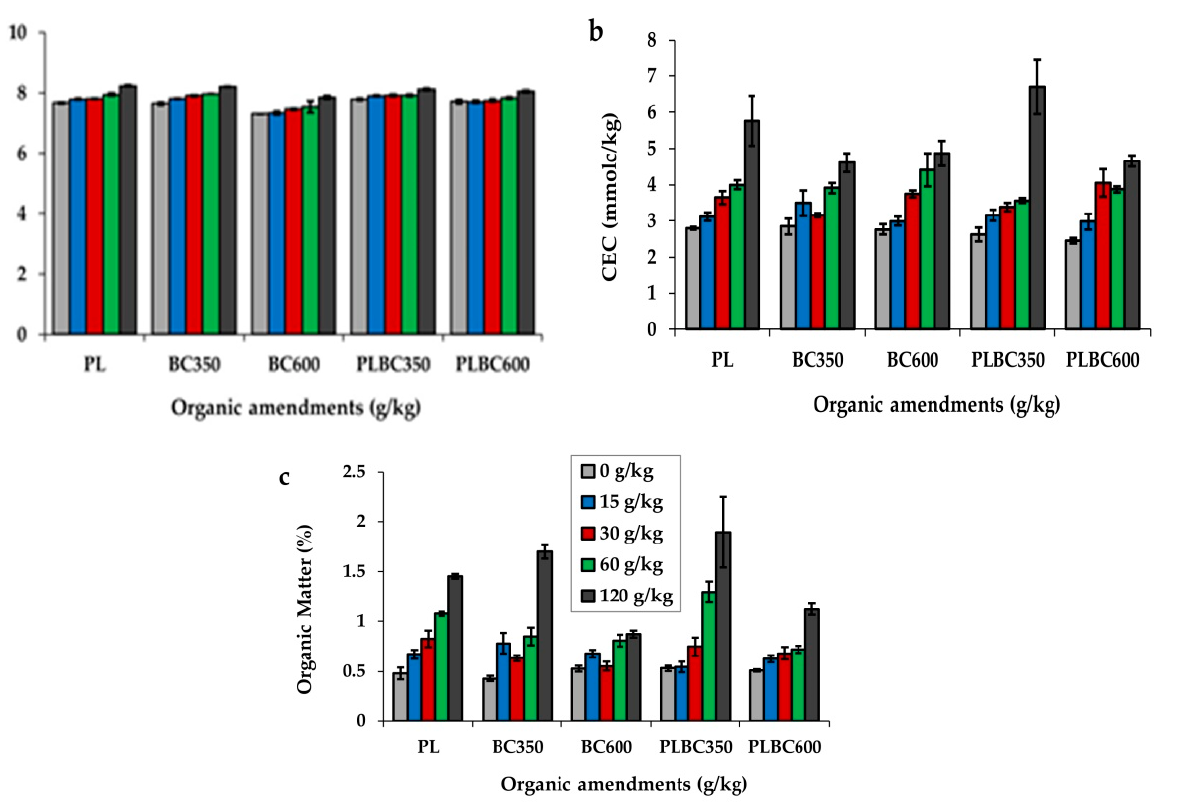
Figure 1. Effects of poultry litter and its biochar on soil pH ( a ), Cation exchange capacity ( b ), and Organic matter content ( c ) at different application rates of 0, 15, 30, 60, and 120 g/kg. Bars represent means and standard errors, n = 3.